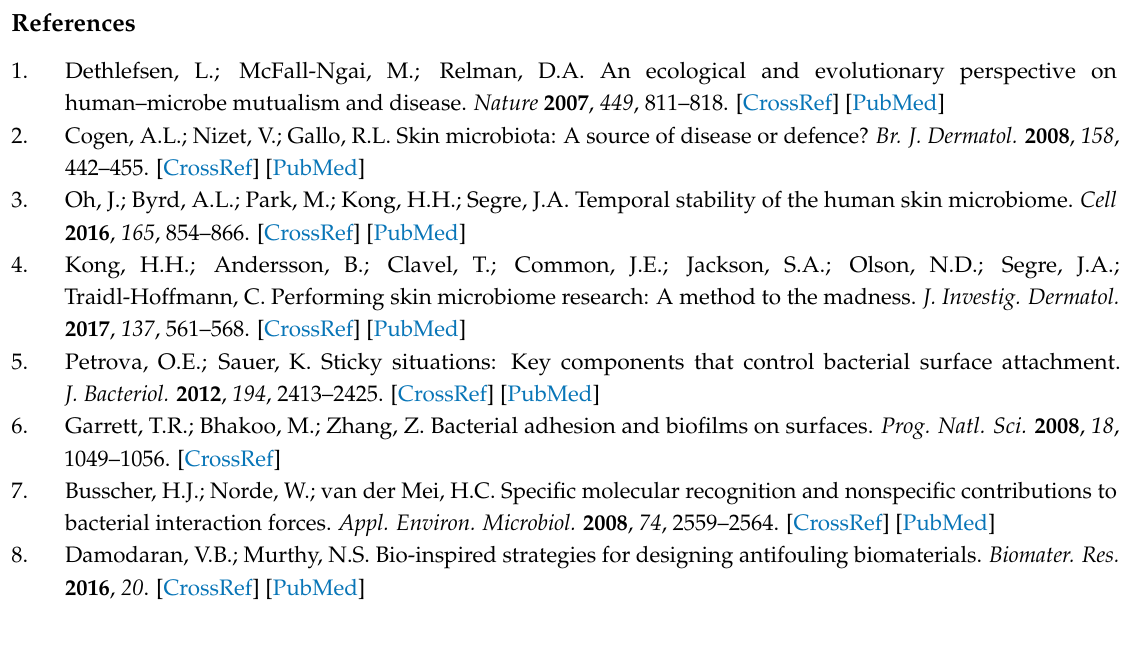
Figure S1: Schematic of the workflow, Table S1: List of ingredients and suppliers used in this study. Author Contributions: All authors (K.C.E., S.A.M., V.C., S.W.W. and D.W.K.) conceived and designed the the